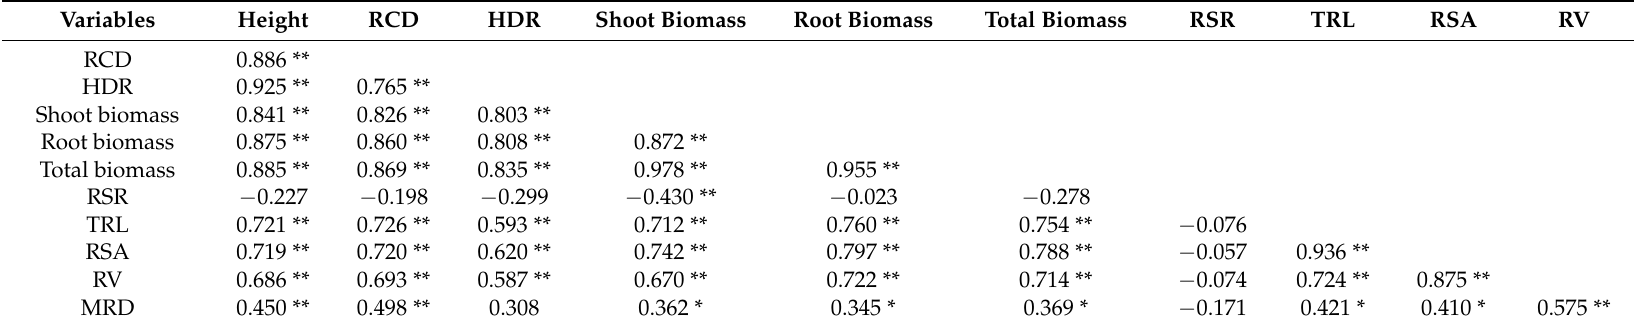
Table 6. Correlation matrix of seedling morphological variables measured (Pearson coefficients, two-tailed, n =